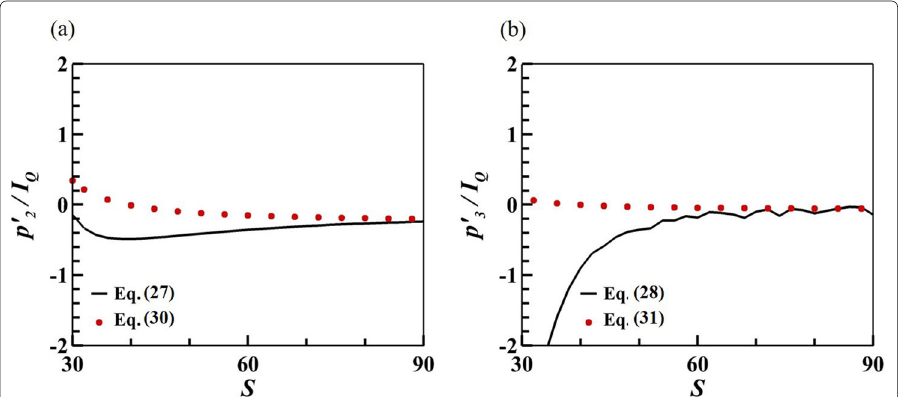
Fig. 6 Sound pressures correspond to ( a ) the second term and ( b ) the third term at different observer distances S . The sound pressures corresponding to the second term are computed by using the Eqs. (27) and (30), respectively. The sound pressures corresponding to the third term are computed by using the Eqs. (28) and (31), respectively. The sound pressures at the non-time dimensional time t = 120 are plotted. The convecting Mach number of the vortex is M a = 0.4 and the observers are distributed along the line with θ = 0